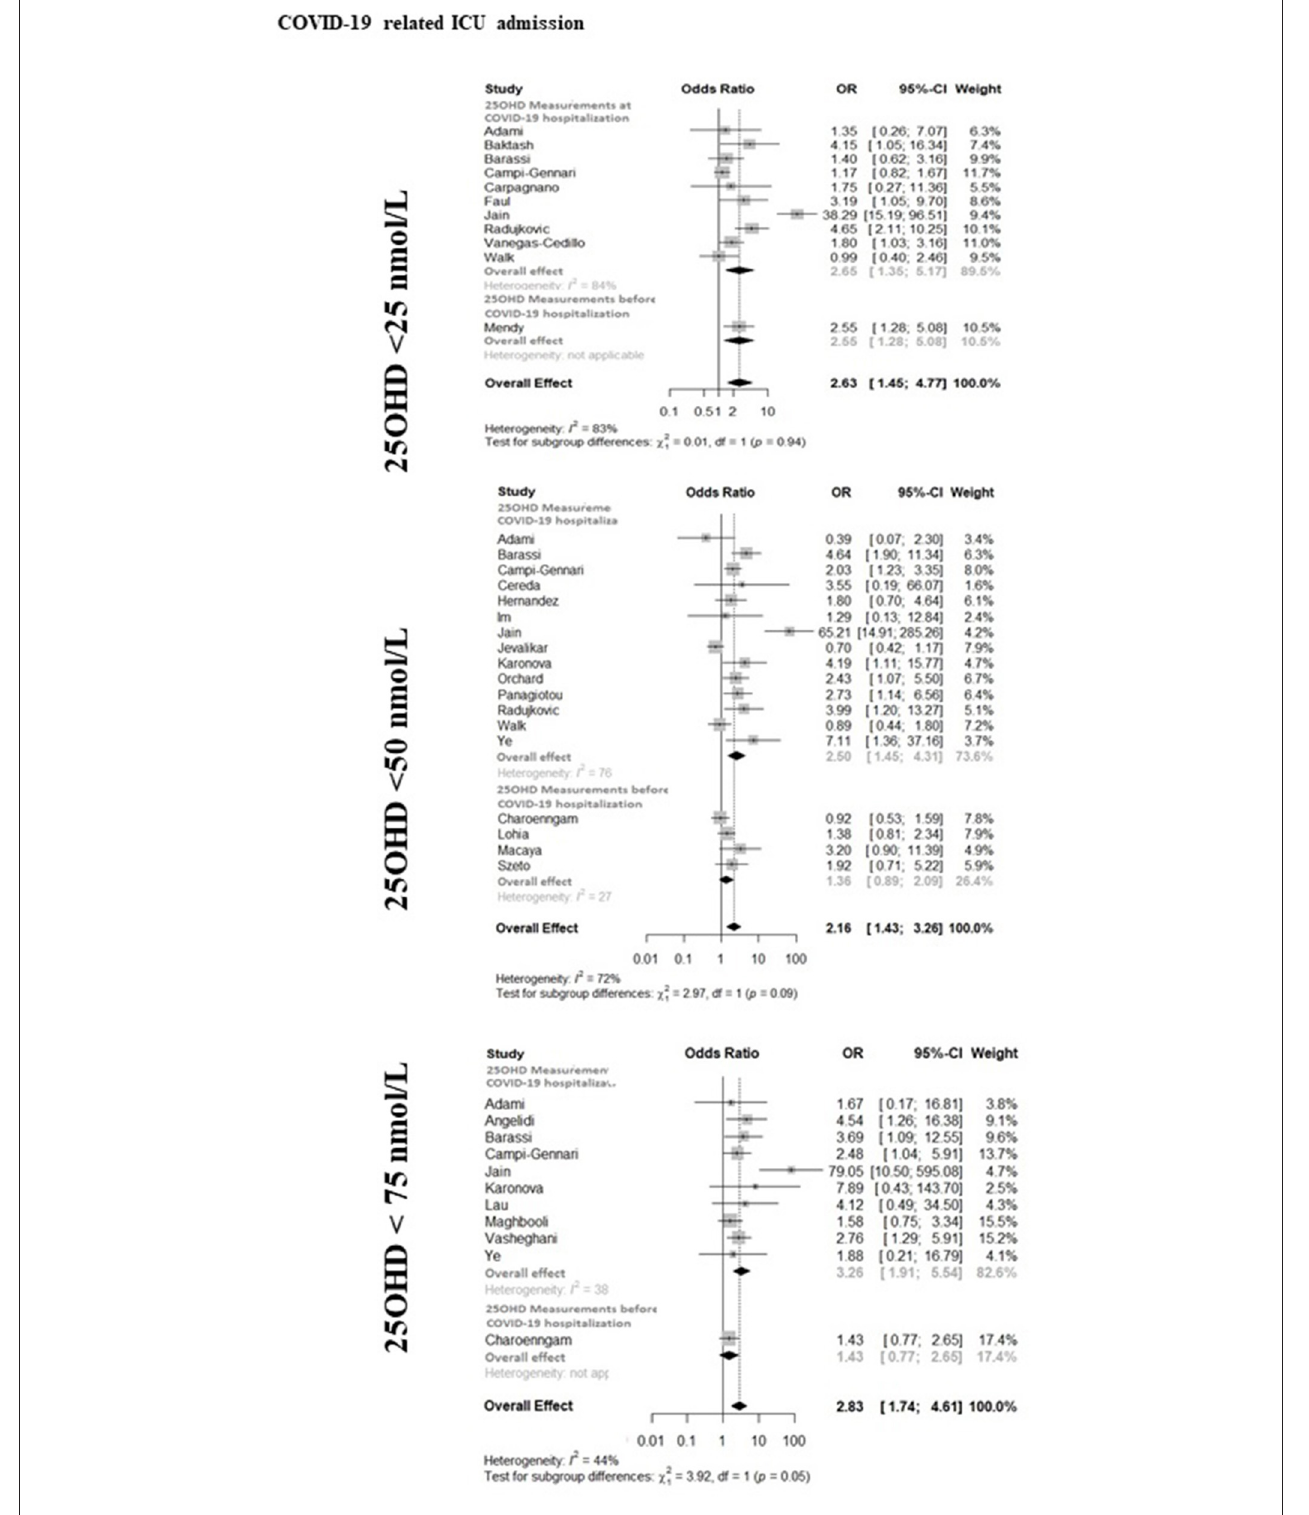
FIGURE 2 | The forest-plot reporting the association between COVID-19 related admission to intensive care unit (ICU) and vitamin D thresholds (severe vitamin D deficiency, vitamin D deficiency, and vitamin D insufficiency). COVID-19, Coronavirus Disease-2019; ICU, intensive Care Unit; < 25 nmol/L, 25OHD levels below 25 nmol/L; < 50 nmol/L, 25OHD levels below 50 nmol/L; < 75 nmol/L, 25OHD levels below 75 nmol/L.